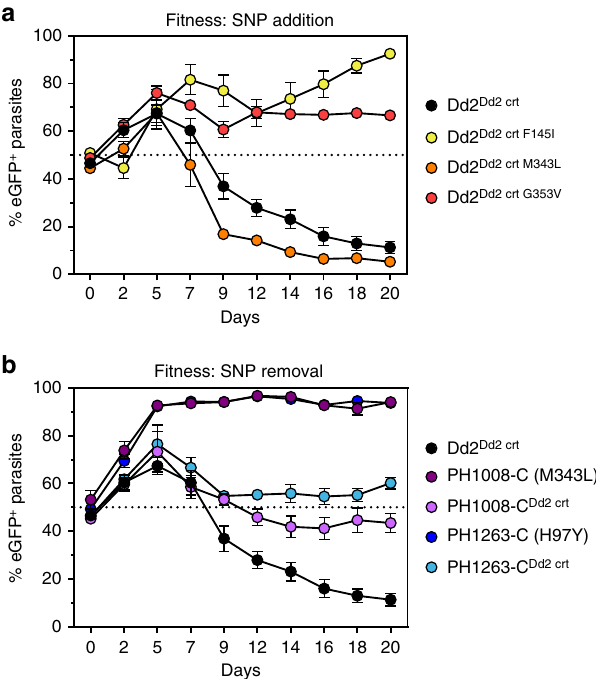
Fig. 5 PfCRT mutations mediate different impacts on P . falciparum growth rates in vitro. pfcrt -edited lines were co-cultured for 20 days with a GFP- expressing Dd2 line and cultures were sampled every 2 – 3 days by fl ow cytometry. Experiments were conducted on two separate occasions in triplicate, and the mean ± SEM percentage of GFP + parasites were plotted over time. Values below the 50% dashed line indicate that a line was fi tter than GFP + parasites. a Results with PfCRT SNPs added to the Dd2 PfCRT haplotype in recombinant Dd2 parasites. Only the M343L mutation had comparable fi tness to the Dd2 allele, whereas the two other variants (F145I and G353V) were less fi t. b Results of Cambodian isolates and isogenic lines with novel PfCRT SNPs removed, showing improved fi tness in the lines lacking H97Y or M343L. Raw data are presented in Supplementary